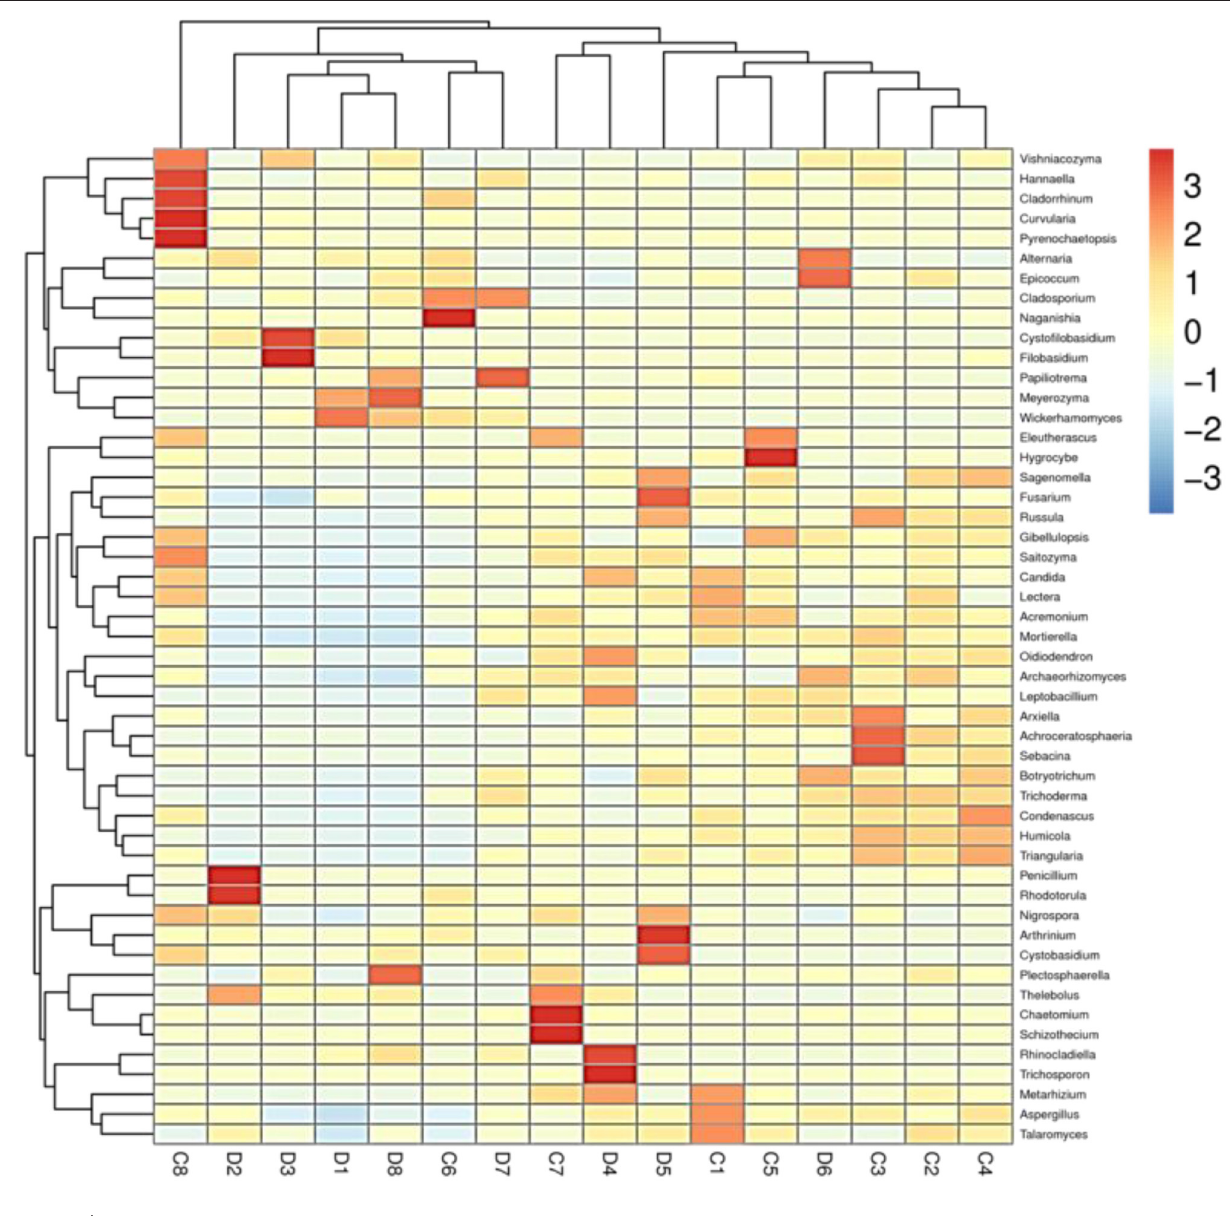
FIGURE 5 | Heatmap at genus level of each sample (top